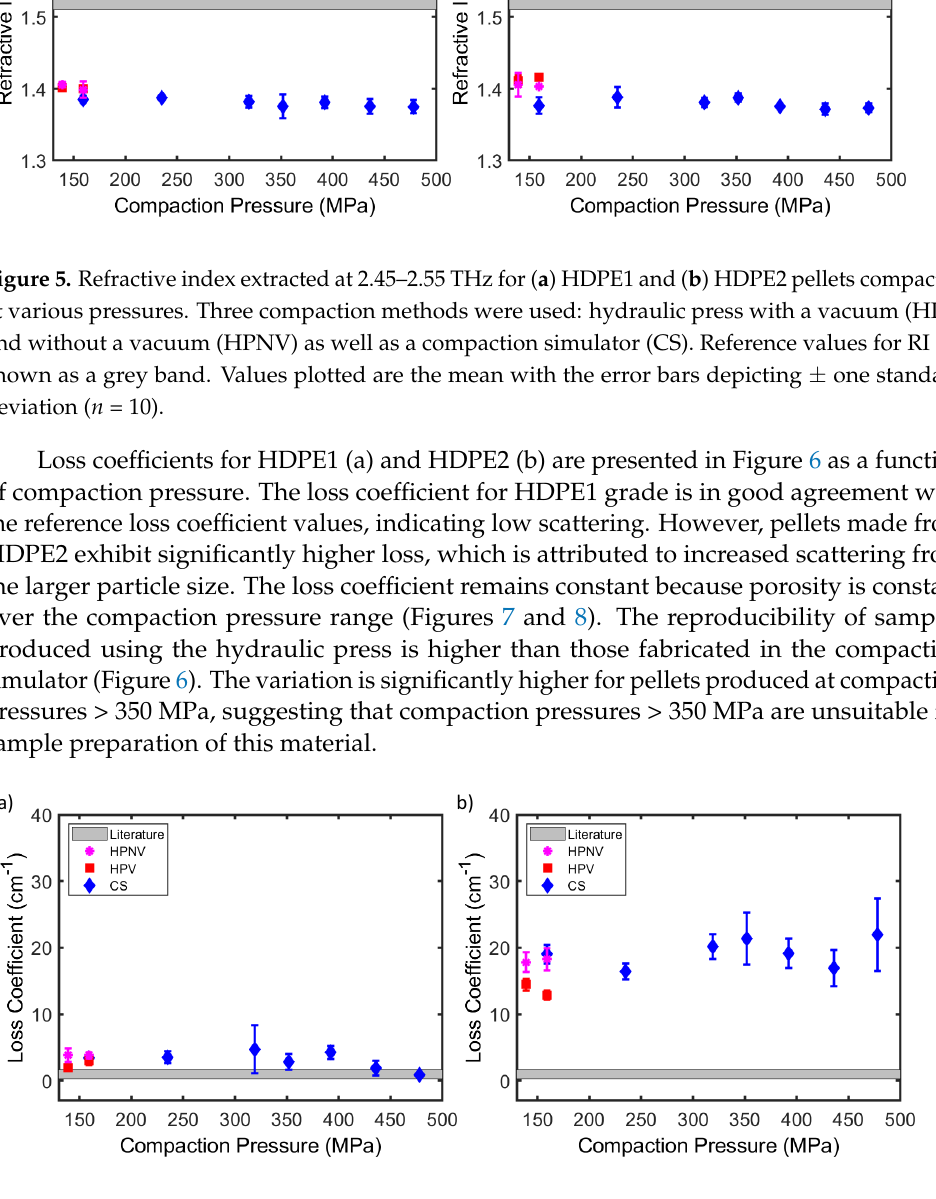
Figure 6. Loss coefficient extracted at 2.45–2.55 THz for ( a ) HDPE1 ( b ) and HDPE2 pellets compacted at various pressures.Three compaction methods were used: hydraulic press with a vacuum (HPV) and without a vacuum (HPNV) as well as a compaction simulator (CS). Reference values for RI is shown as a grey band. Values plotted are the mean with the error bars depicting ± one standard deviation ( n =